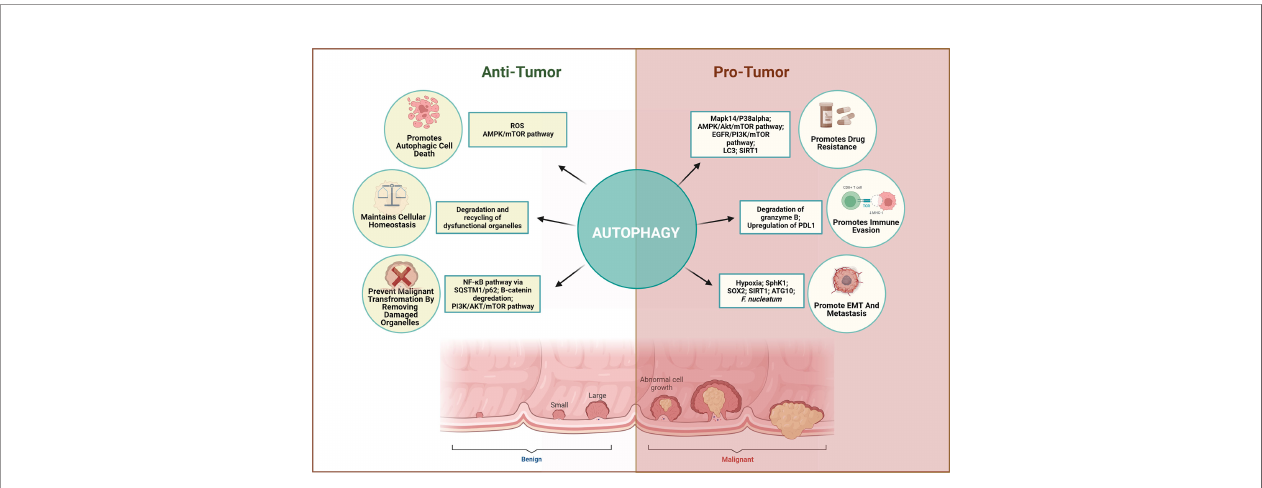
FIGURE 3 | Dichotomous role of autophagy in CRC. Autophagy plays a complex and context-dependent role. On one hand, it can protect against abnormal survival by promoting autophagic death of tumor cells, maintain homeostasis and remove dysfunctional organelles in early stages, while on the other hand, it can promote tumor growth by favoring immune evasion, EMT, angiogenesis, and resisting the therapeutic effects when cancer has